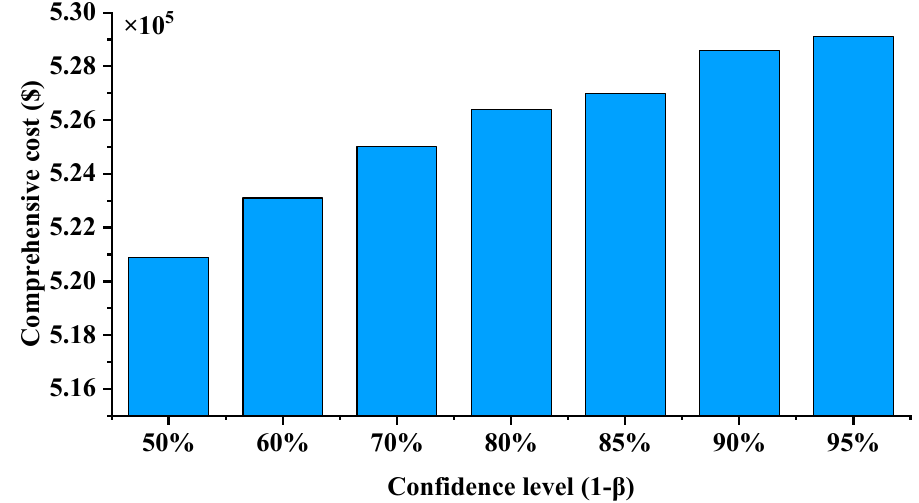
Figure 8. Comprehensive cost with confidence level.